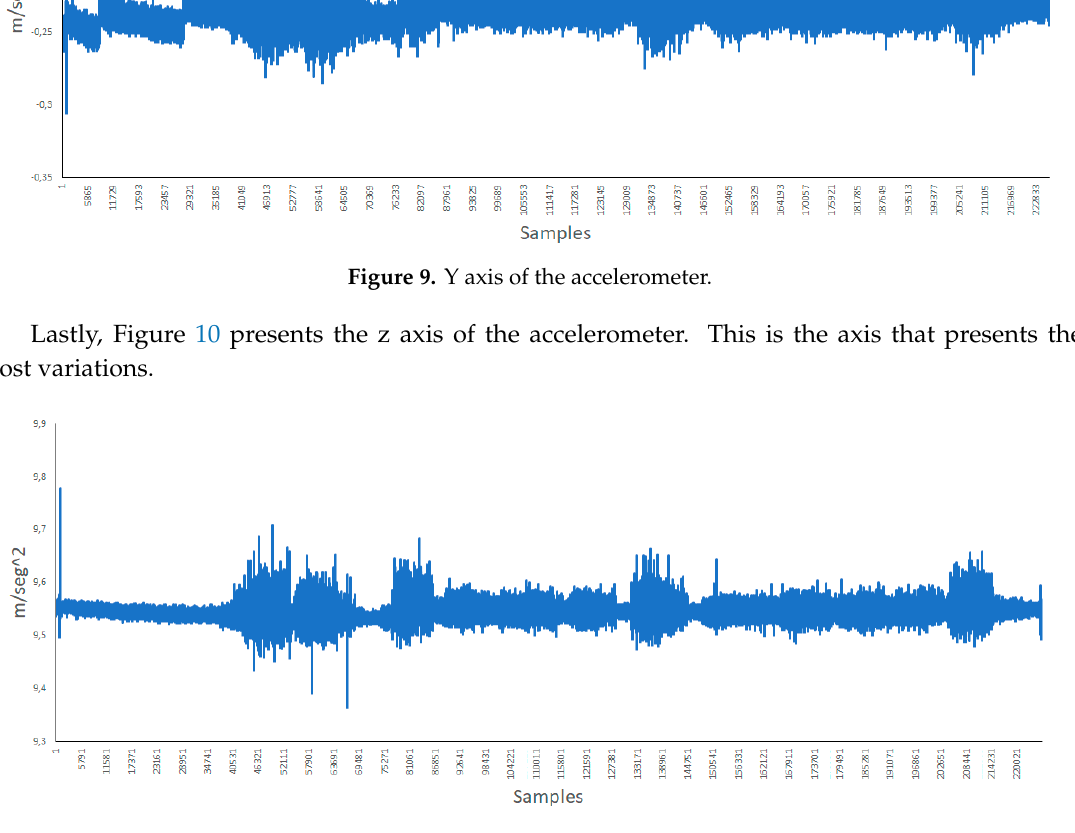
Figure 10. Z axis of the accelerometer.